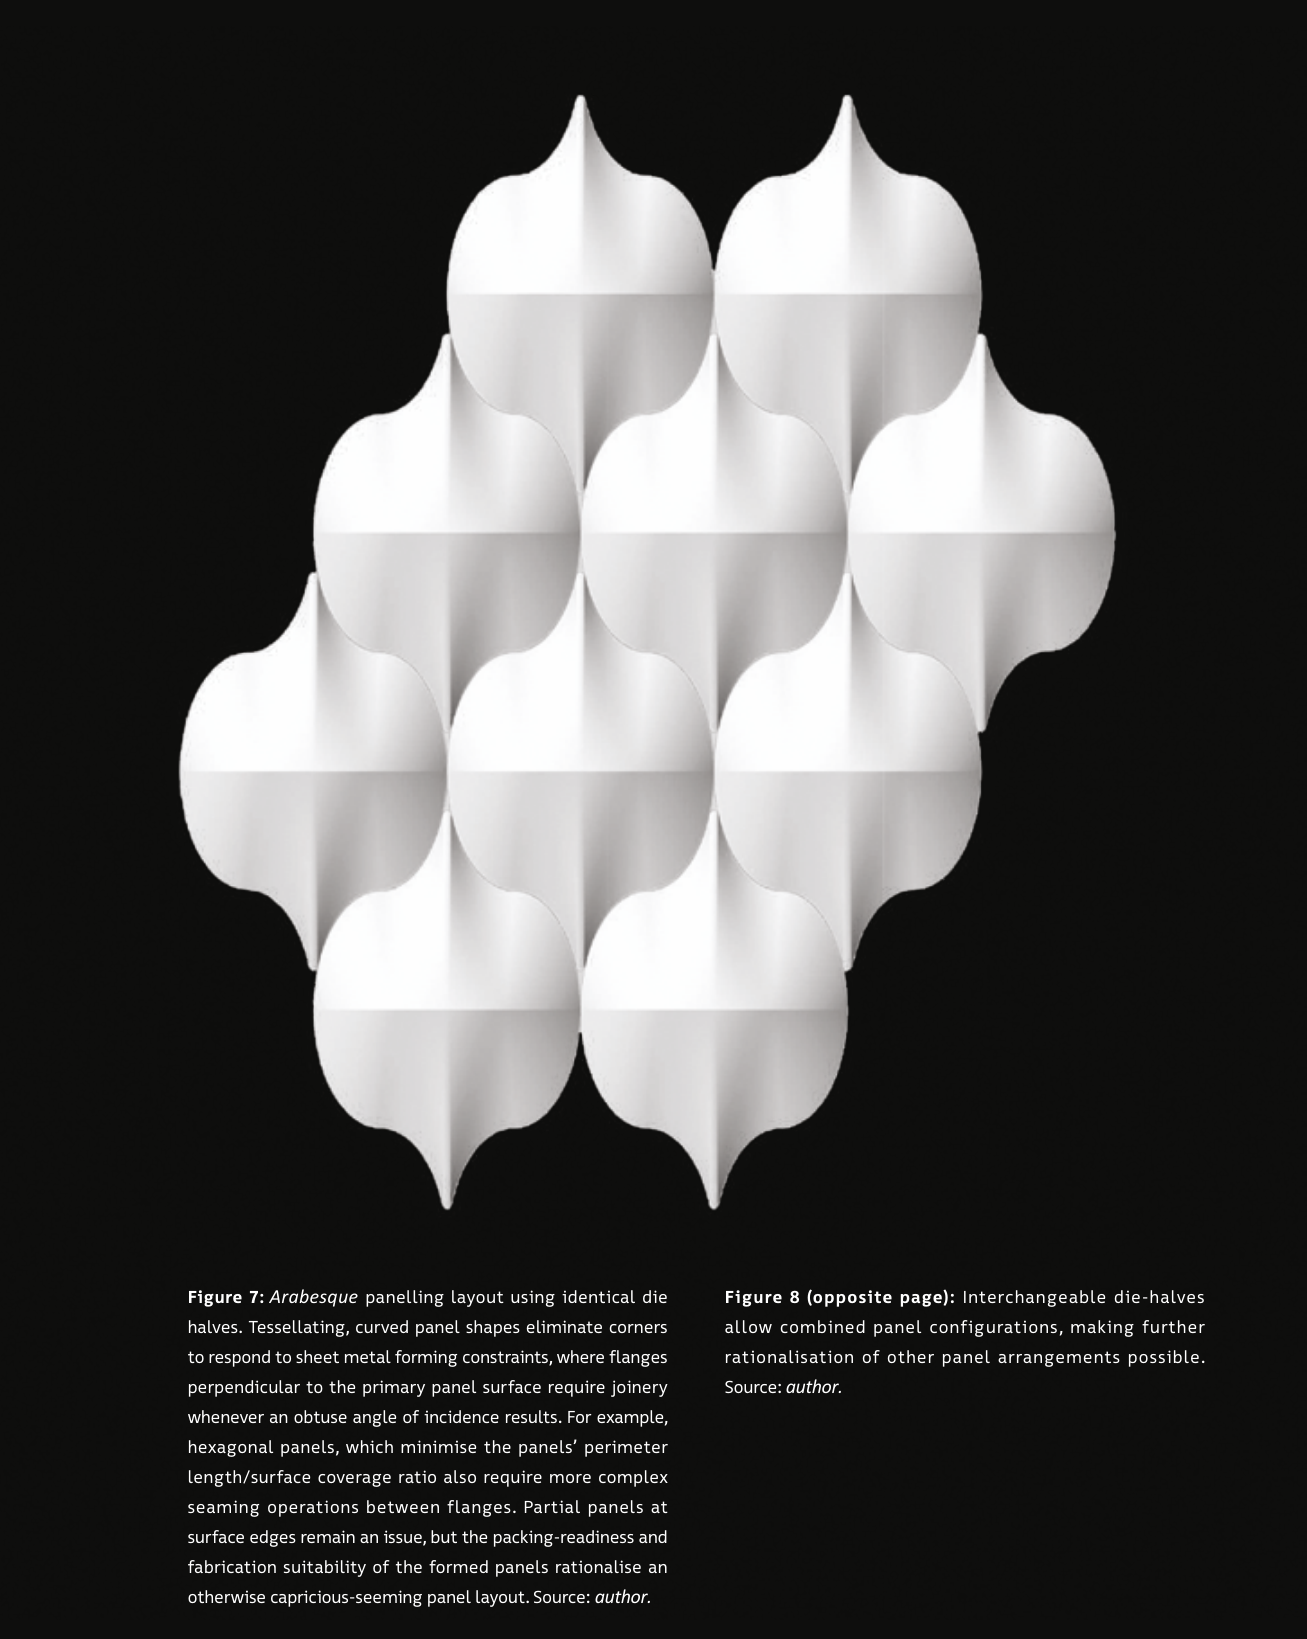
Figure 7: Arabesque panelling layout using identical die halves. Tessellating, curved panel shapes eliminate corners